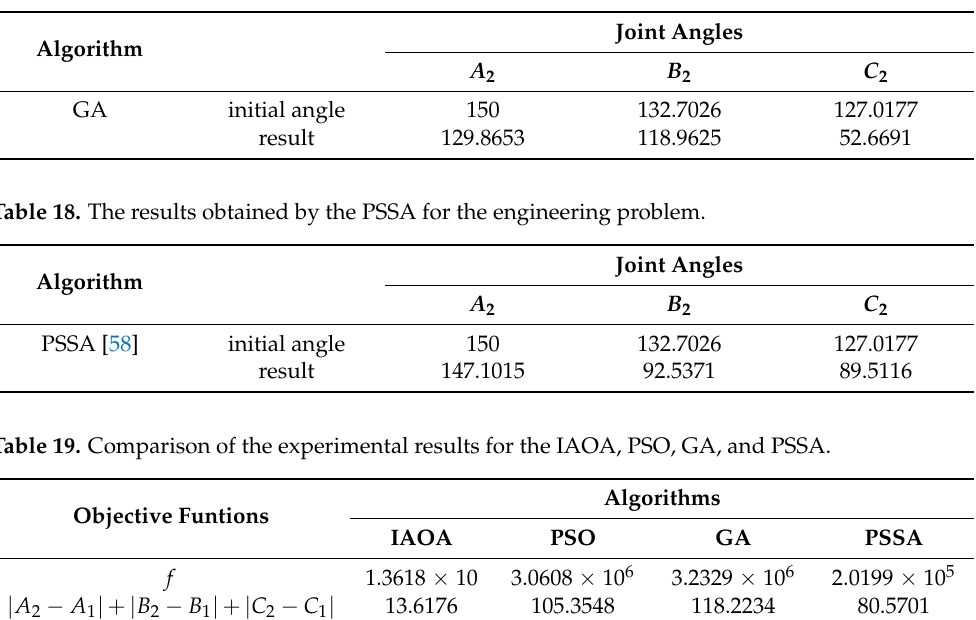
Table 17. The results obtained by the GA for the engineering problem.